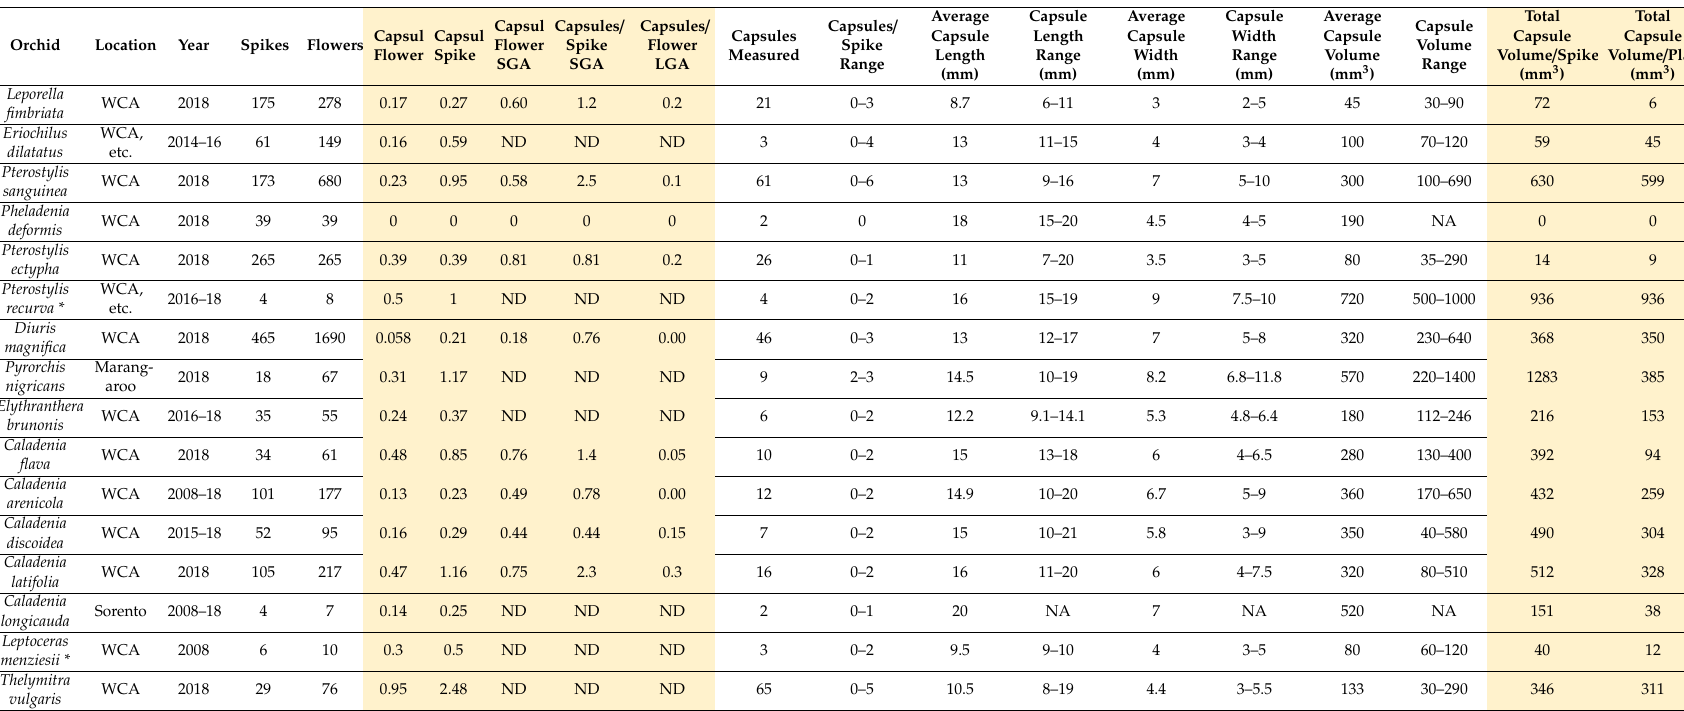
Table A2. Capsule numbers, sizes and volumes for each species. Totals per plant include flowering and non–flowering plants. Shaded columns show reproductive vital